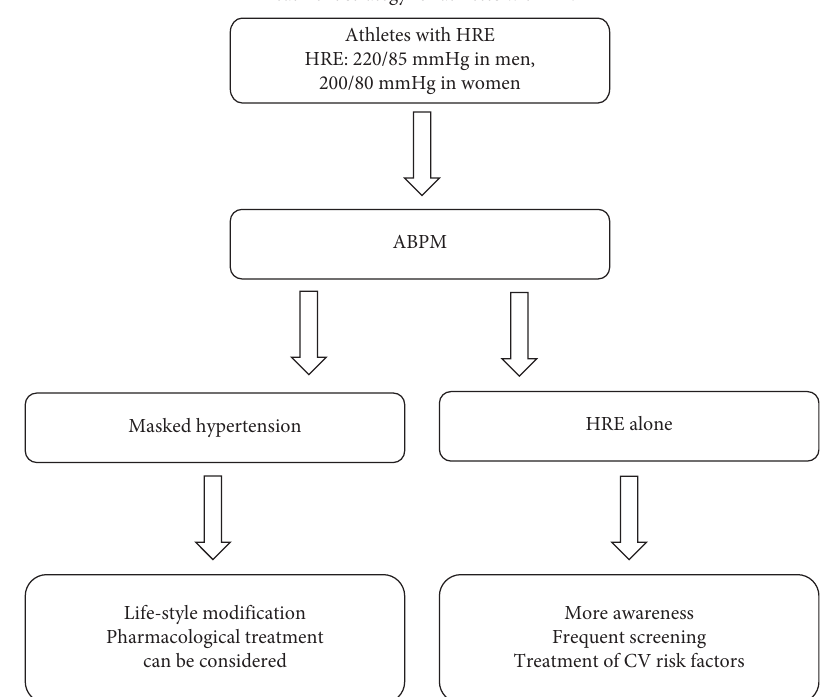
Figure 2: Diagnostic and therapeutic procedure for athletes with HRE. Tis fgure shows a schematic treatment strategy for athletes with HRE. After the identifcation of HRE in athletes, an ambulant blood pressure monitoring (ABPM) should be performed to diagnose a possible masked hypertension. Depending on the fndings of the ABPM, a suitable therapy can be applied.